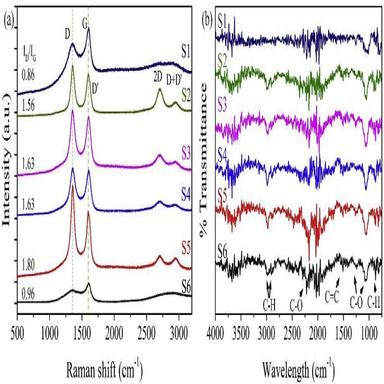
(a) Raman spectra depict structural variations through S1 to S6 where intensities ID/IG are indicated. (b) FTIR analysis developed through S1 to S6 where signals related to CeH, CeO, and C]C are observed. (A colour version of this figure can be viewed online.)